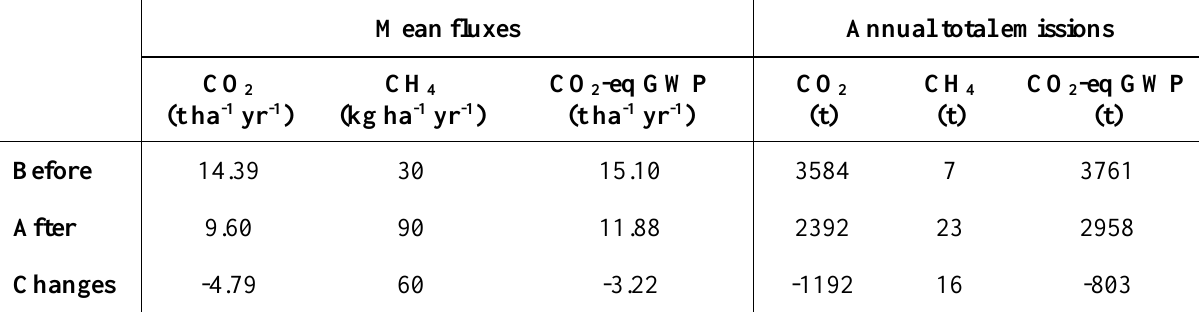
Table 2. Changes in mean GHG fluxes and total emissions before and after